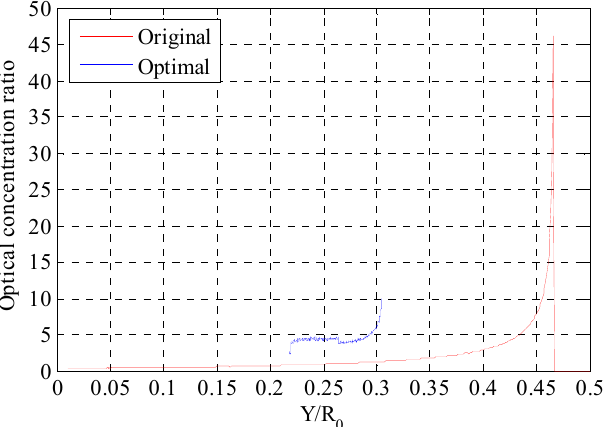
Figure 8. Illustration of energy distribution before and after optimization. Table 3. Parameters before and after optimization.